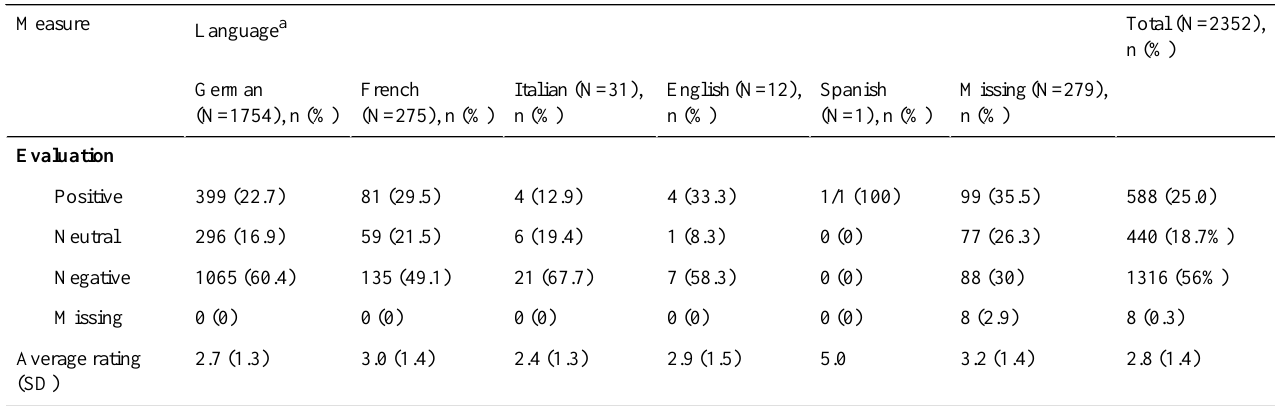
Table 3. Quantitative rating evaluation